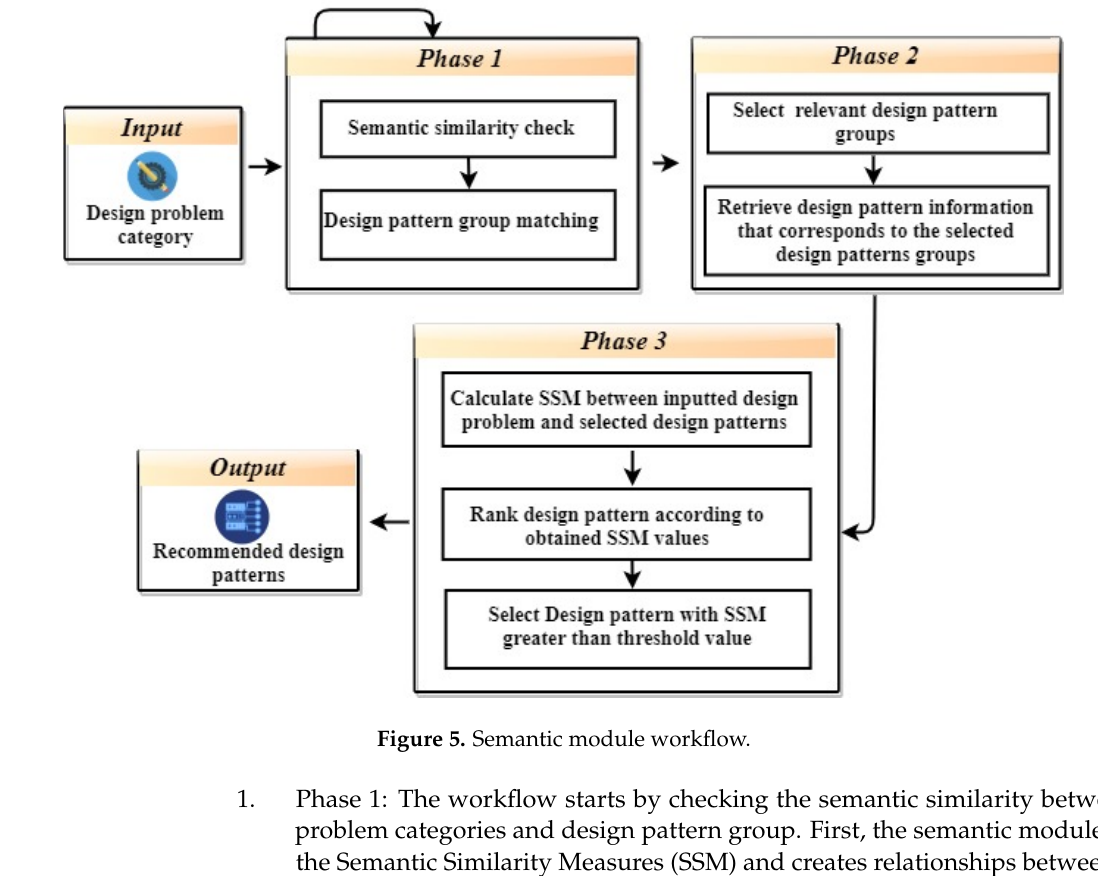
Figure 5. Semantic module workflow.